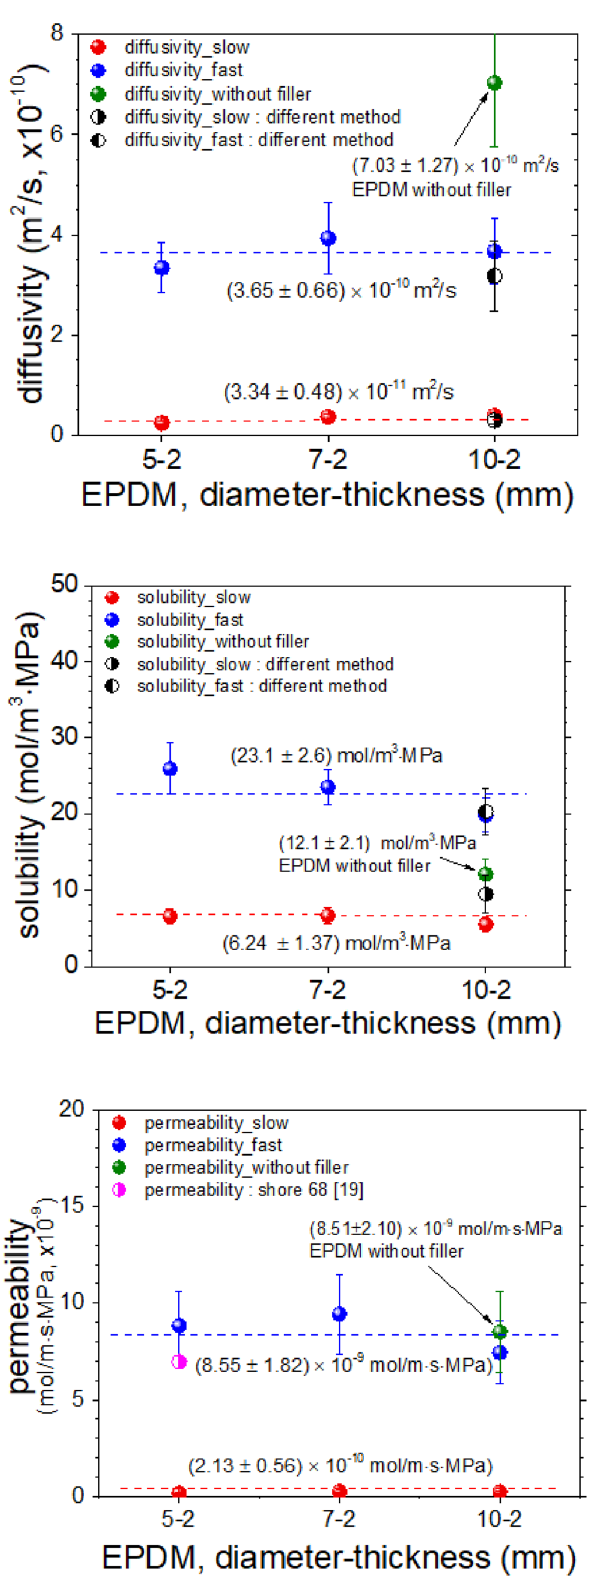
Figure 10. Permeation characteristics according to the size of the EPDM